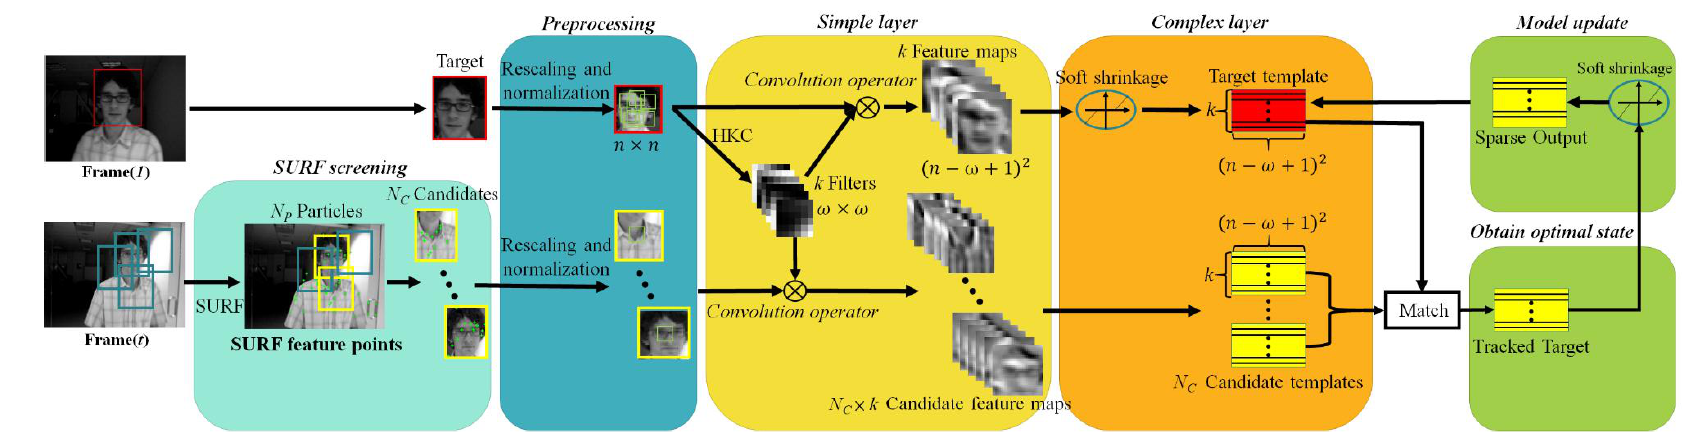
Figure 1. Flowchart of the proposed Fast-CNT.